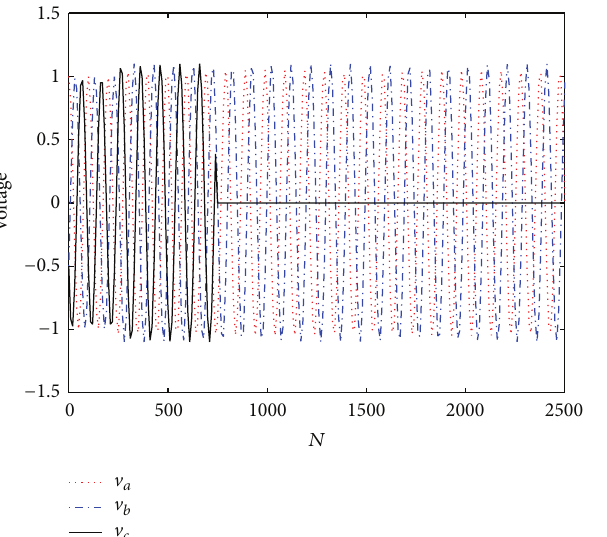
Figure 5: Mean estimated frequency versus 𝑁 under harmonic contamination.